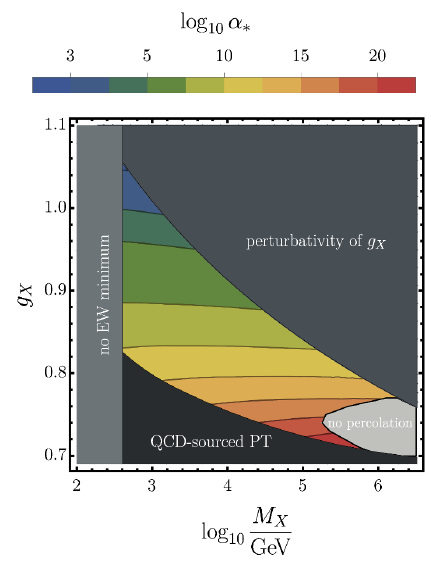
Figure 9 . The values of transition strength parameter α ∗